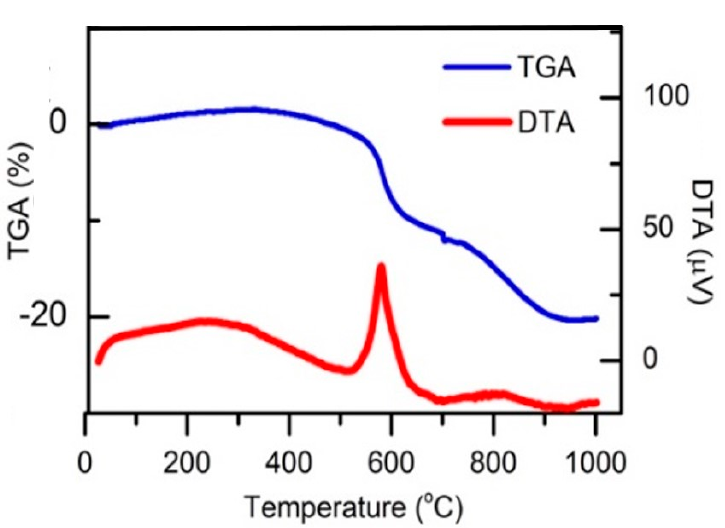
Figure 2. Differential thermal analysis curve of samples using a planetary ball mill after 8h-milled.